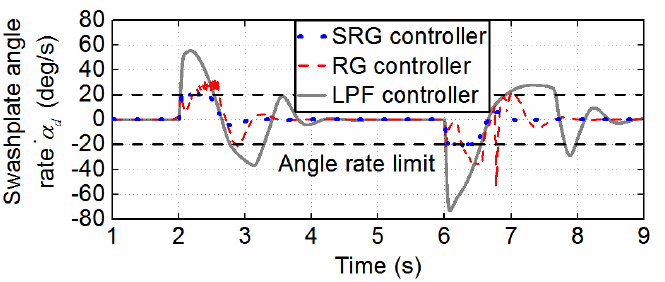
Figure 9. Actuator control inputs of the three controllers for a step trajectory from 10 bar to 70 bar.